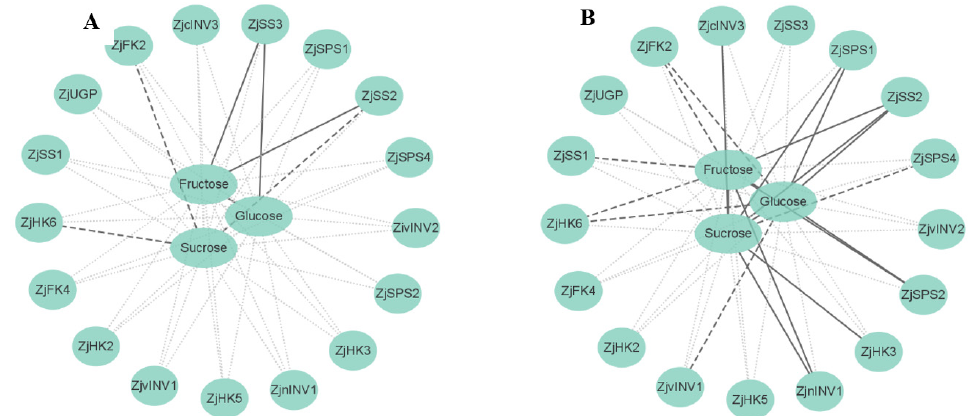
Figure 6. Correlations between metabolite contents and gene expression. ( A ) Correlation analysis of sugar metabolism in leaves. ( B ) Correlation analysis of sugar metabolism in fruits. Sucrose synthase (SS), sucrose phosphosynthase (SPS), invertase (INV), fructokinase (FK), pyrophosphorylase (UGP), hexokinase (HK). Gray dashed lines between indices represent no correlations, whereas black dashed and solid black lines represent negative and positive correlations at significant levels ( p < 0.05), respectively. Correlations analysis was drawn using Cytoscape 3.6.1. The sucrose, fructose, and glucose contents in fruits were positively correlated with each other. Sucrose content was positively correlated with ZjSS2 , ZjSPS1 , ZjnINV1 , ZjcINV3 , and ZjHK3 expression but negatively correlated with ZjSPS4 expression. Fruc-